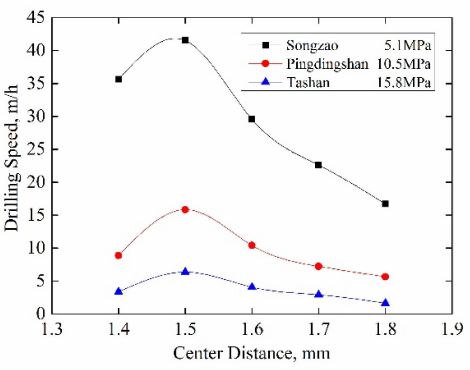
Figure 10. Graph showing the relationship between self-drilling speed and forward orifice center distance. Strength of coal samples: 5.1, 10.5 and 15.8